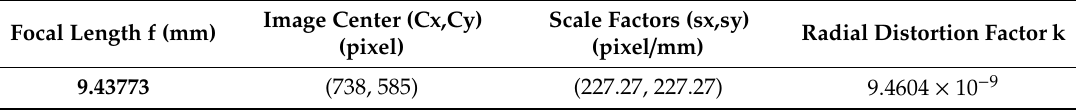
Table 1. Camera intrinsic parameters 1